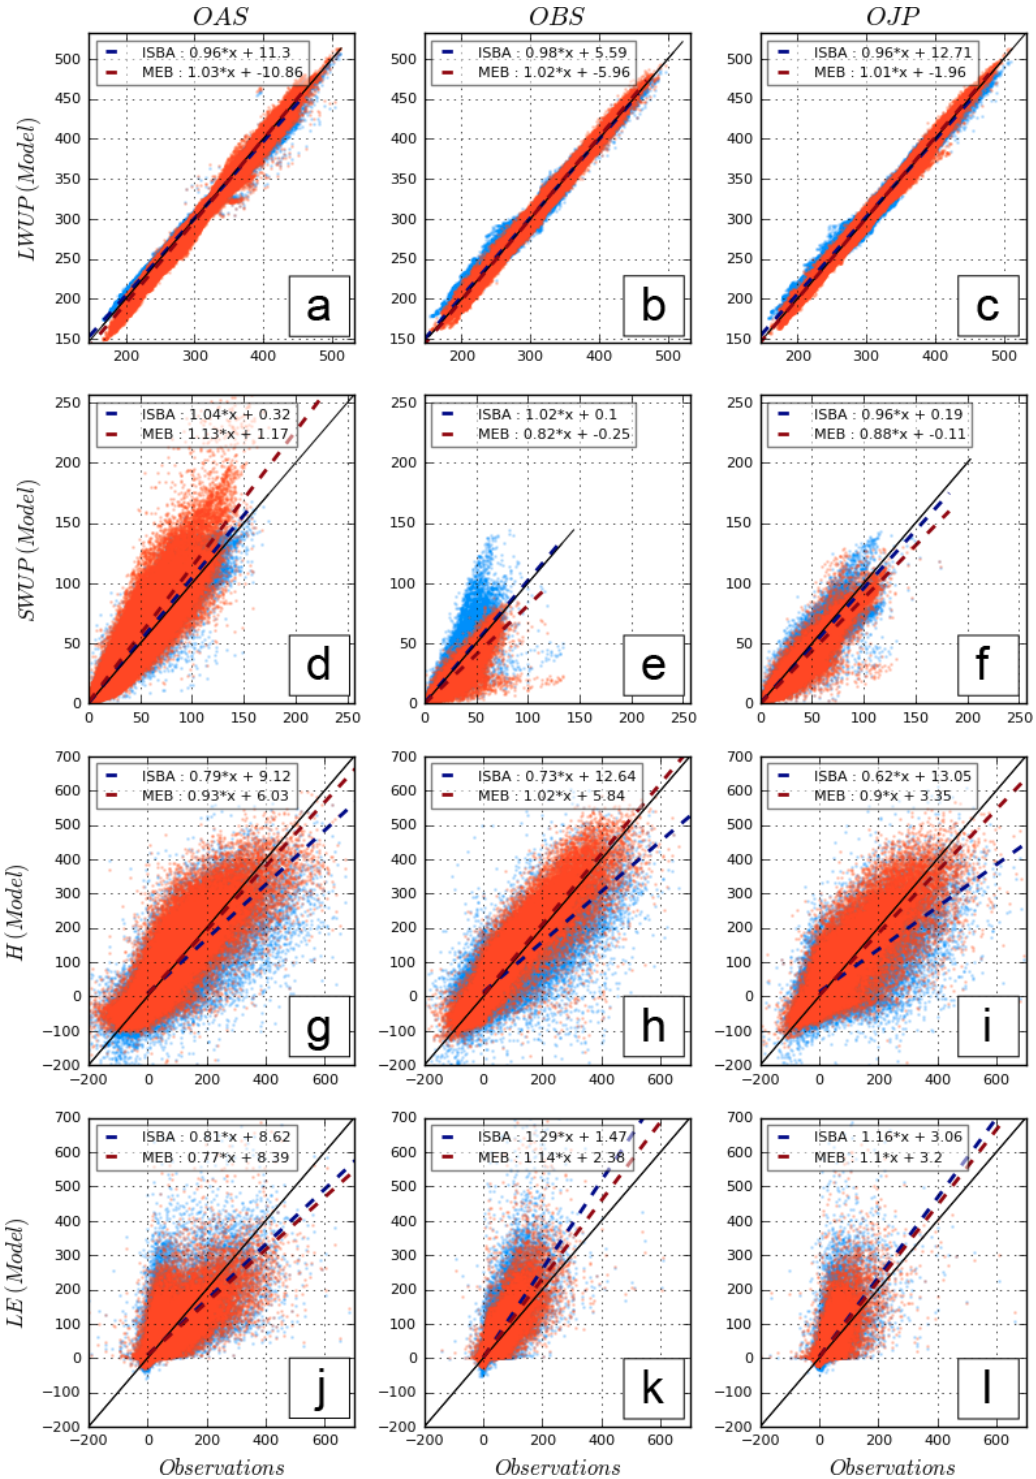
Figure 4. Scatterplots for the different fluxes and the three sites using only observations with snow on the ground. MEB is in red, and ISBA is in